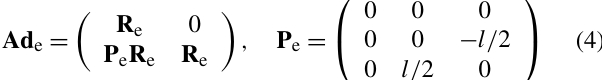
Figure 7. The local coordinate frame O i ( x i ,y i ,z i ) and the global coordinate frame O ( x,y,z